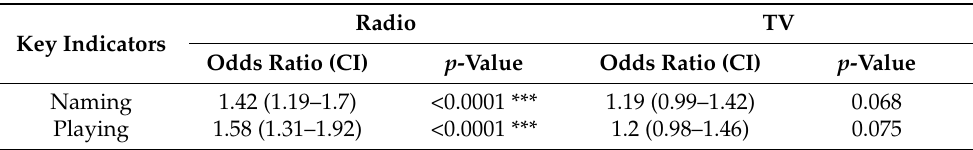
Table 5. Regression Analysis for Male Heads of Household Exposure to Radio, TV, and IPC Interven- tion and Key Practice Indicators, n =